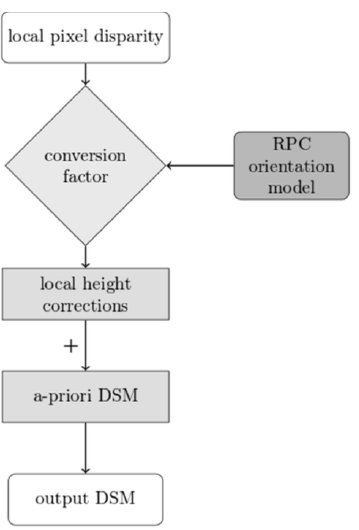
Figure 1: General workflow from pixel disparity to generated DSM